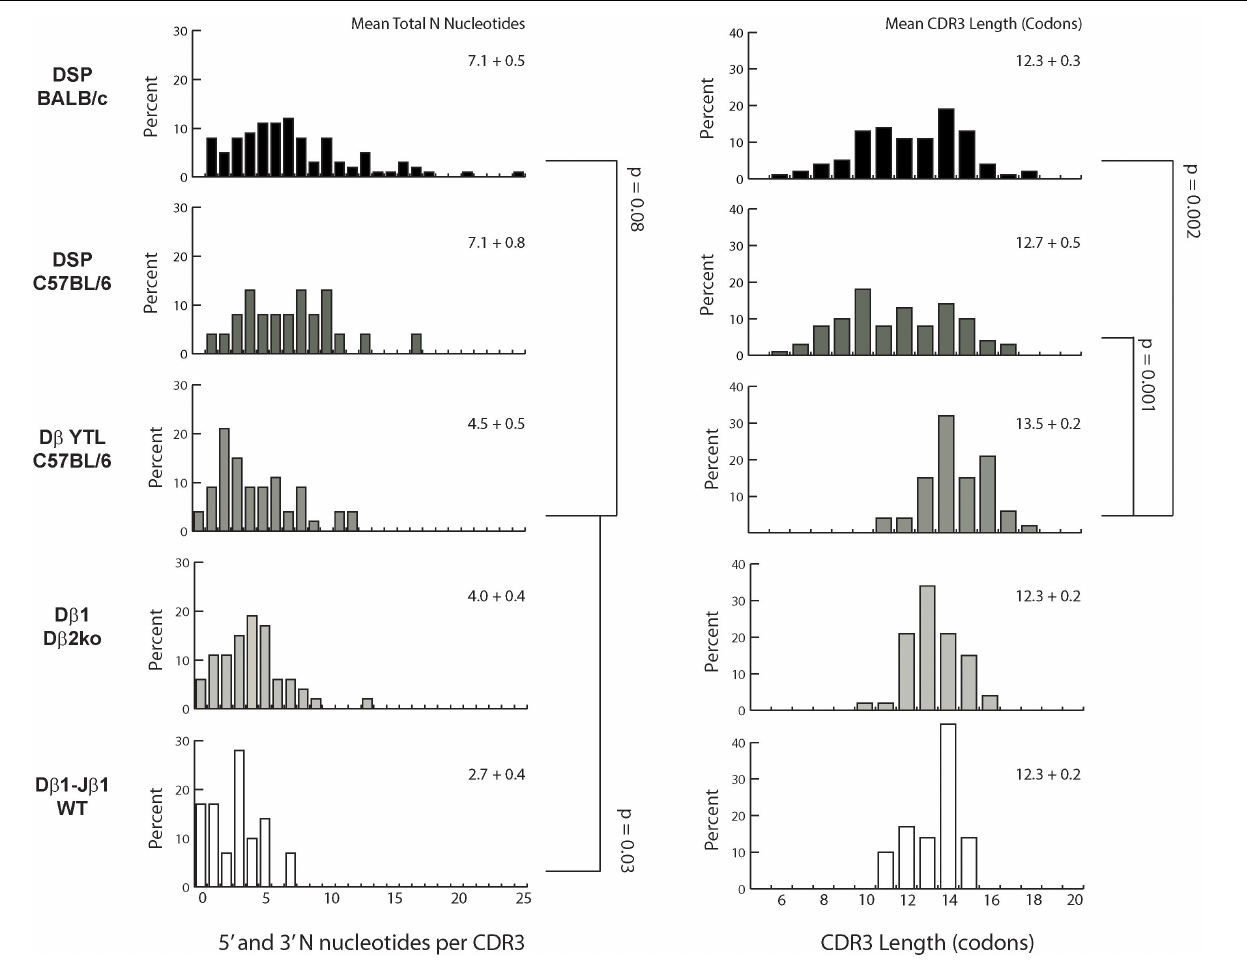
FIGURE 4 | Distribution of total N addition in nucleotides and CDR3 length in codons. Left column: percent of CDR sequences that contain between 0 and 25 N nucleotides. From top to bottom: Fraction B BABL/c and pro B C57BL/6 CDR-H3 sequences, followed by CDR-B3 sequences from D β YTL, D β 2ko, and D β 1 wild type thymocytes. Statistical analysis was performed only for D β YTL in comparison with the four controls, and comparisons lacking a “ p ” value all have p values of > 0.05. Means for the total number of N nucleotides (left column) and for CDR3 length (right column) are given in the upper right of each